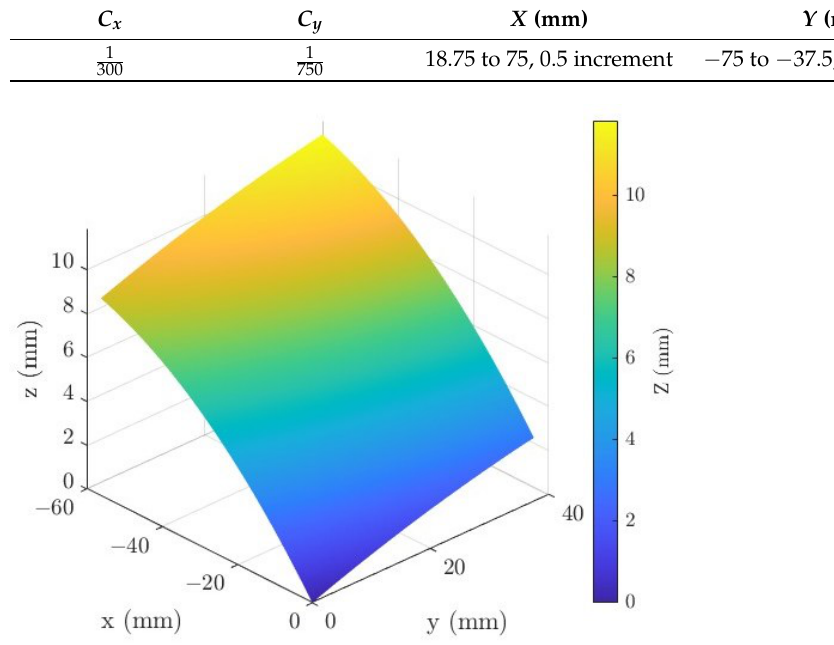
Figure 1. Toroidal freeform surface as modeled for study